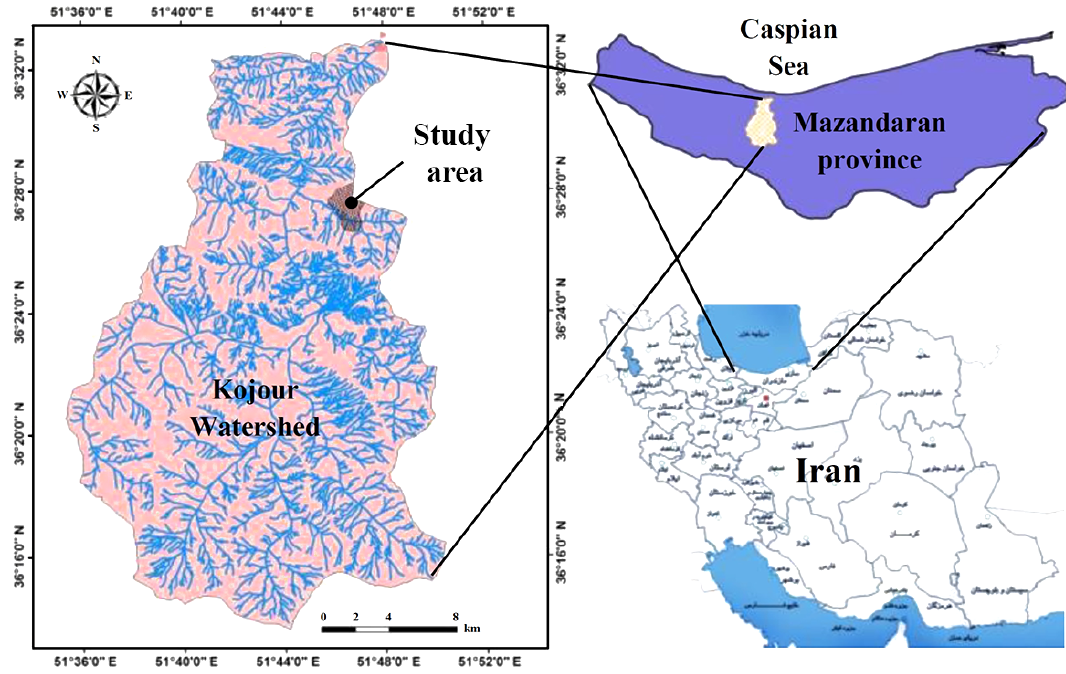
Figure 1. Location of the study area in Kojour watershed, Mazandaran Province,